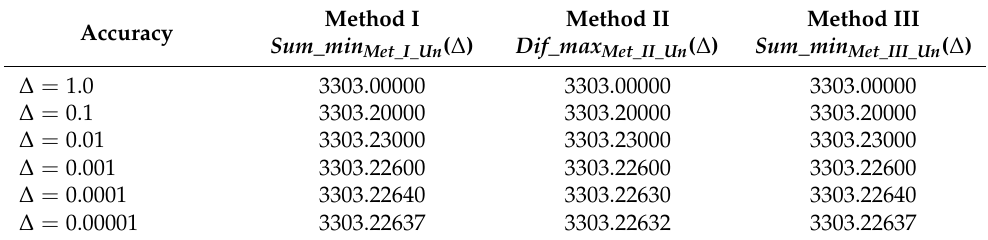
Table 19. Estimated lines lengths d ∆ of the reconstructed image for a given accuracy ∆ using the methods proposed by the